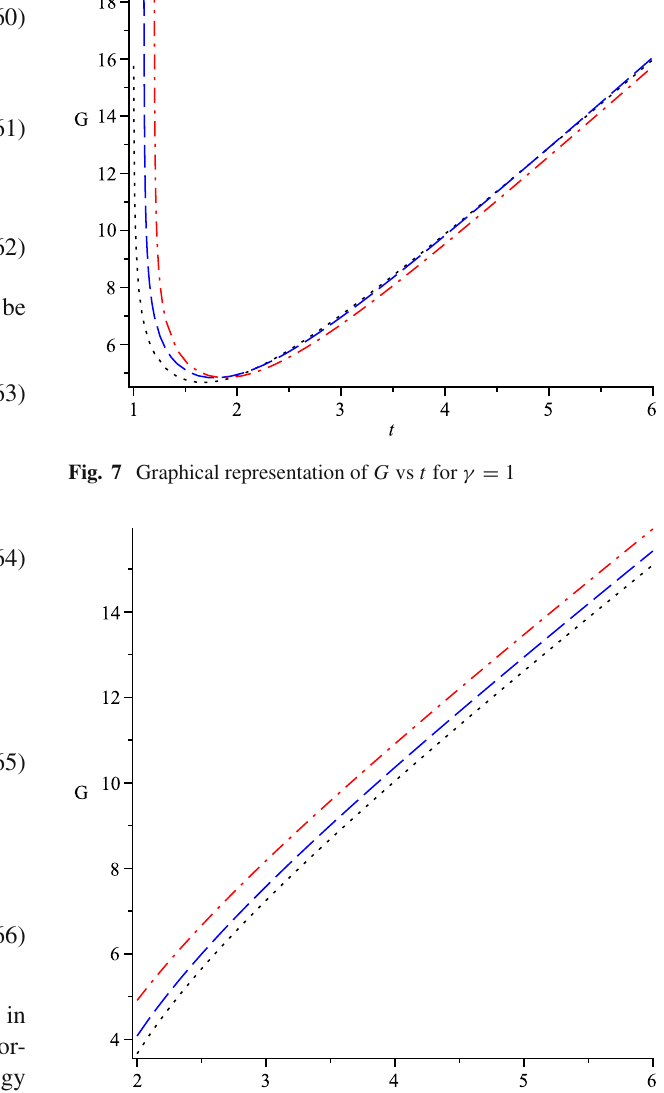
one of the variables become cyclic and the Lagrangian is so simplified that one obtains classical cosmological solu- tions for the choices γ = 1 (stiff fluid) and γ = 0 (dust). The relevant cosmological parameters have been presented graphically (in Figs. 1, 2, 3) for γ = 1 and (in Figs. 4, 5, 6) for γ = 0 and are analyzed from observational point of view. The variation of G with the cosmic time has been pre- sented graphically in Figs. 7 and 8 for γ = 1 and γ = 0 respectively. For the present work, in both the models